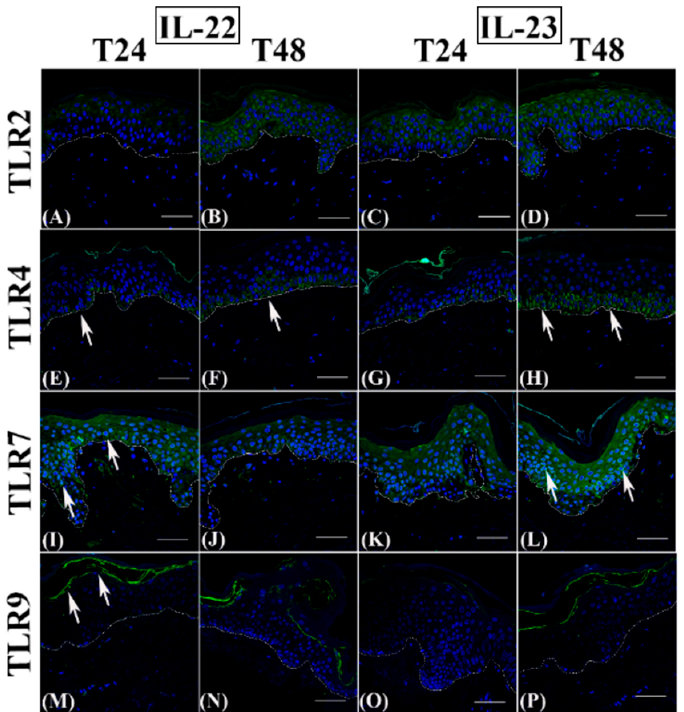
dotted line indicates the basal membrane. White arrows indicate positive immunostaining—scale bars: 50 µ m.